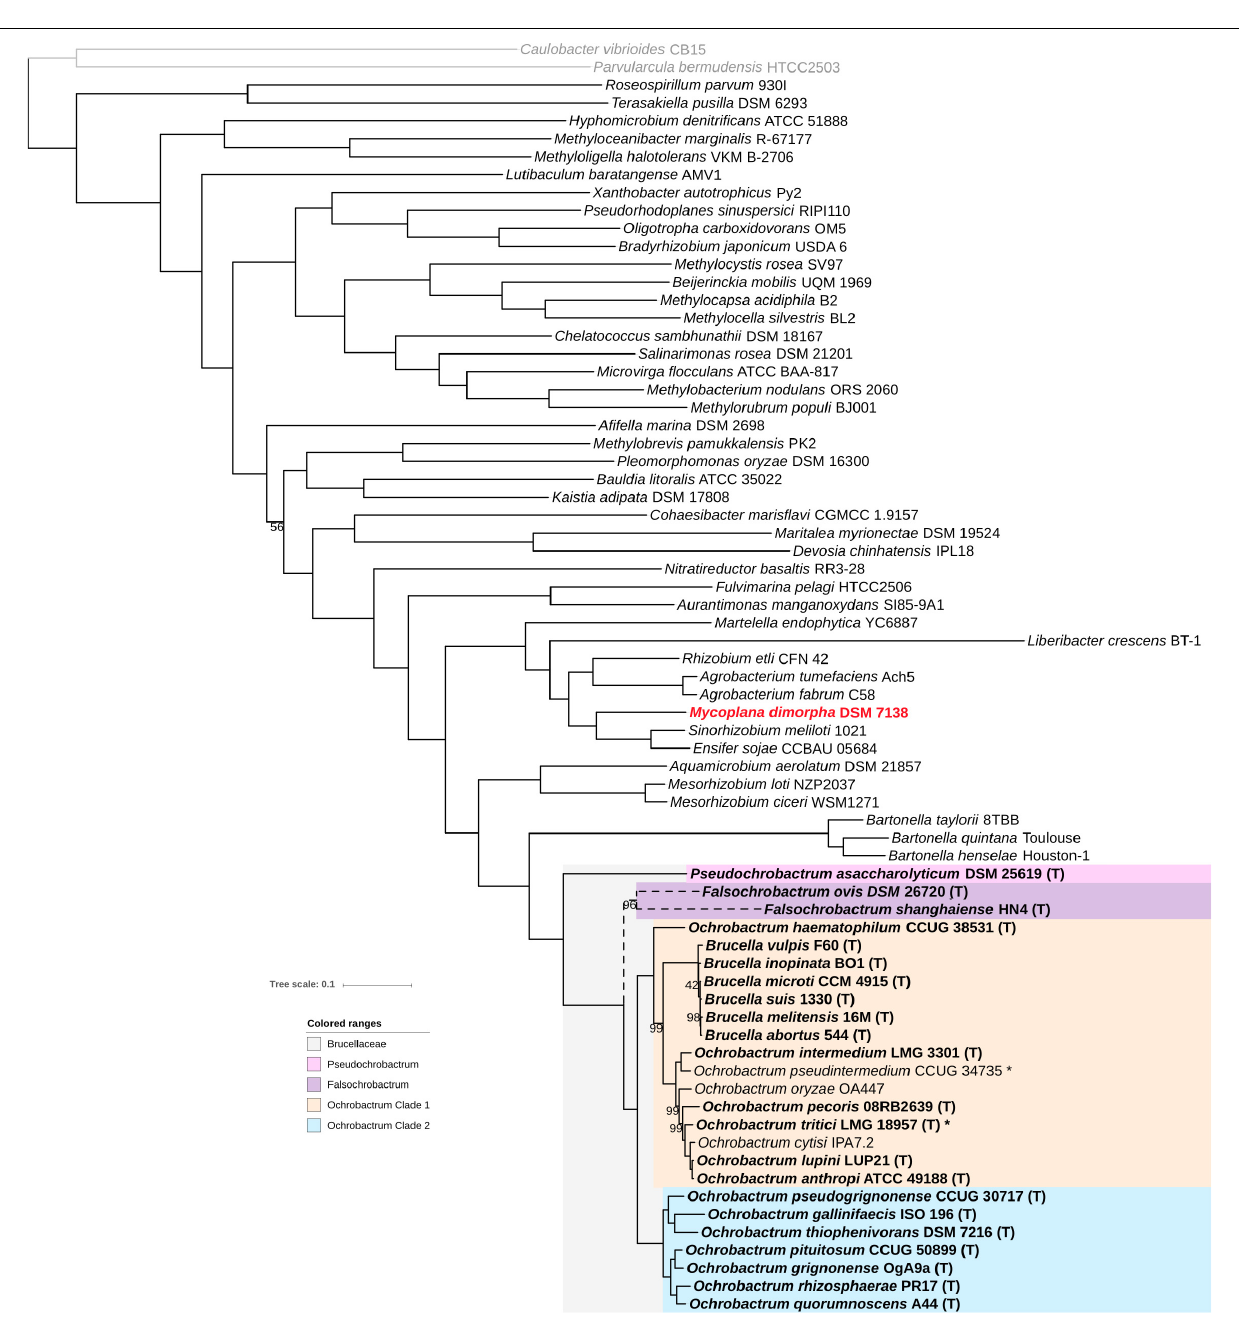
actually more genetically related to most Ochrobactrum spp. of Clade 1 than to Brucella